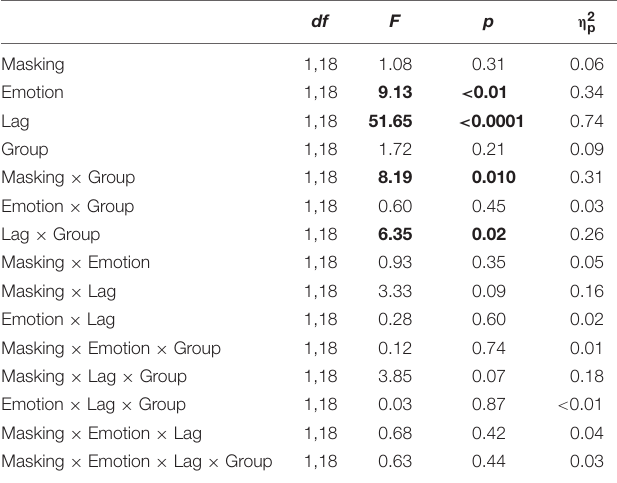
TABLE 2 | ANOVA results Experiment